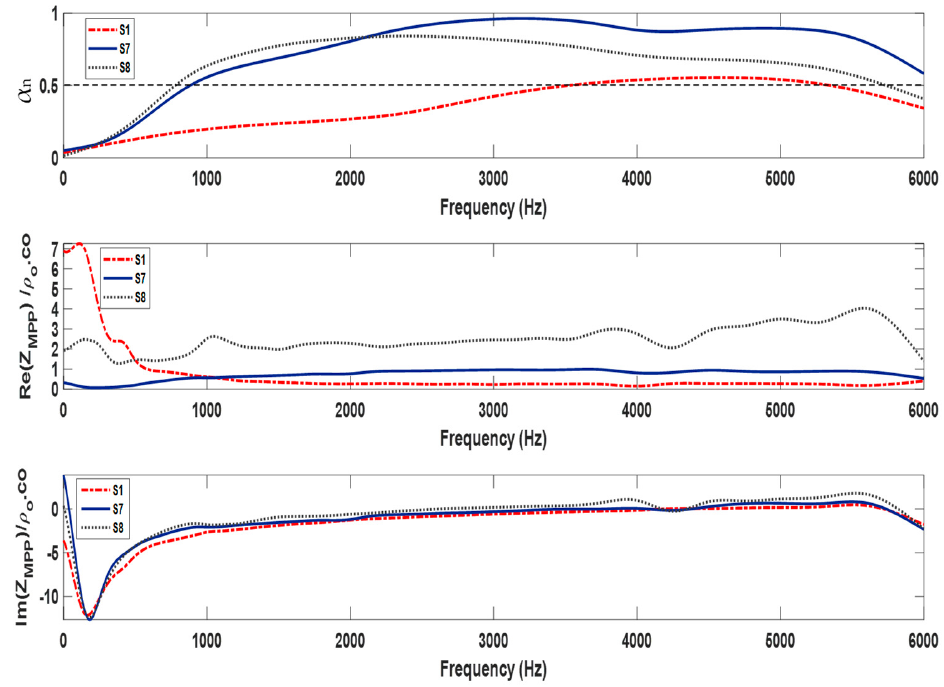
Figure 10. Sound absorption, resistive part, and reactive part of 𝑍(cid:3560) (cid:3014)(cid:3017)(cid:3017) for woven fabric S1, S7, and